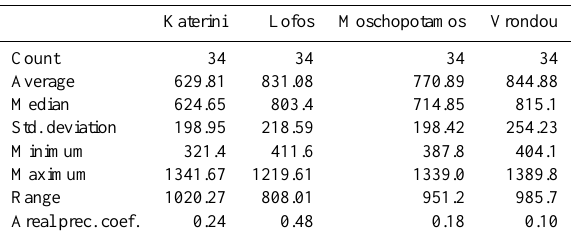
Table 2. Summary statistics of the annual precipitation time series